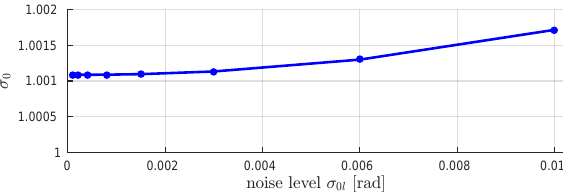
Figure 4. The standard deviation (cid:98) σ 0 of the estimated variance factor at different noise level σ 0 l . With focal length c = 1587 . 87 pixel, 0.001 radian corresponds to an uncertainty of 1 . 5 pixel in the image points.